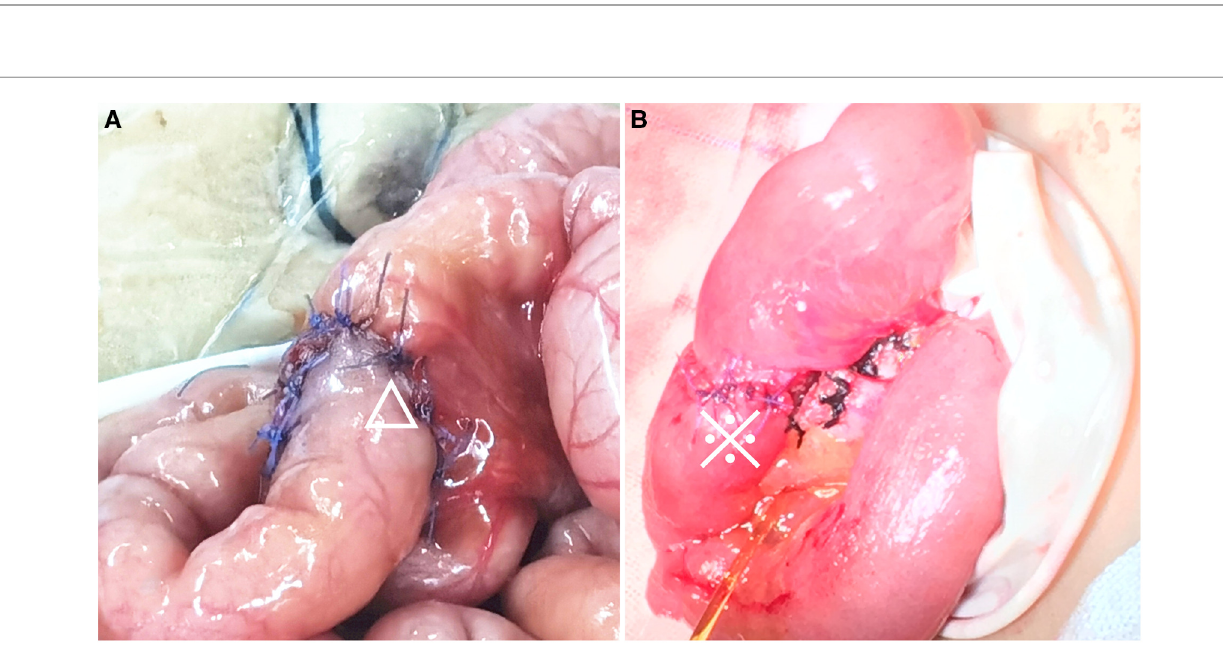
FIGURE 3 Comparison of the asymmetric fi gure-of-eight suture technique and traditional single-layer suture technique. ( A ) A 50-day-old boy with biliary atresia undergoing Kasai portoenterostomy, completion of end-to-side jejuno-jejunal anastomosis ( △ ); ( B ) a six-year-old boy with Meckel ’ s diverticulum complicated by strangulated internal hernia undergoing necrotic bowel resection and end-to-end ileoileal anastomosis ( ※